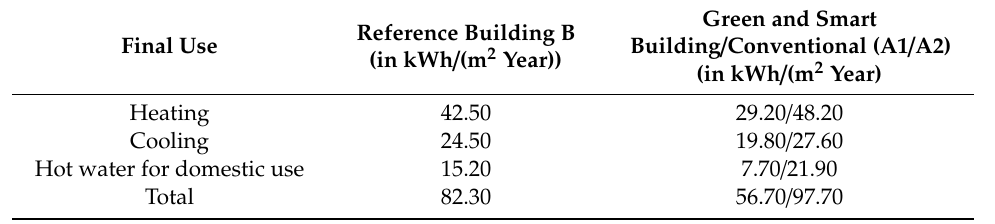
Table 4. Profile of the reference building’s requirements (according to the National Technical Standards) and the A1 building regarding the energy consumption per domestic